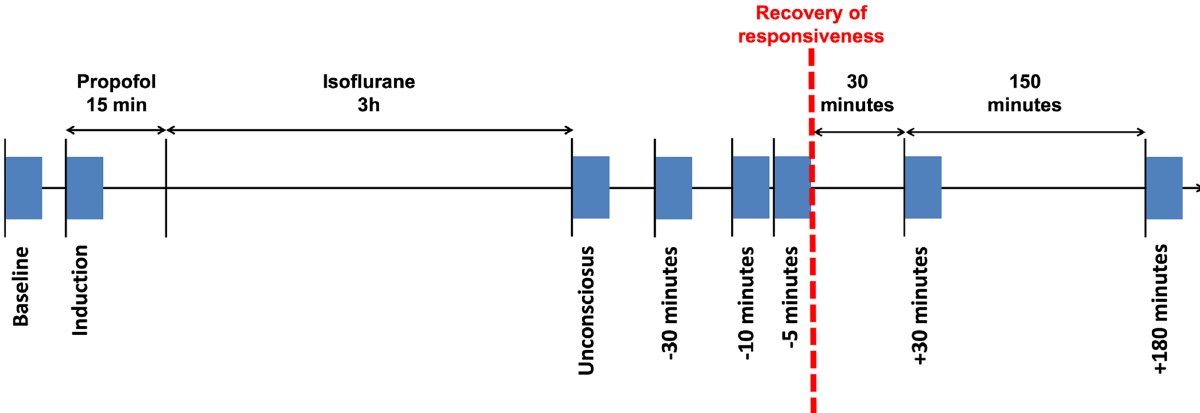
Figure 1. Experimental design and timeline. Timeline of anesthetic protocol and EEG data epochs. Participants received a stepwise increasing infusion rate of propofol for 15 min: 100 mcg/kg/min × 5 min increasing to 200 mcg/kg/min × 5 min, and then to 300 mcg/kg/min × 5 min. Participants then received 1.3 age-adjusted minimum alveolar concentration inhaled isoflurane anesthesia for 3 h. Blue rectangles represent the eight 5-min EEG epochs during which network properties and motifs were calculated: (1) Baseline; (2) Induction; (3) Unconscious; (4) 30 min pre-recovery of responsiveness (ROR); (5) 10 min pre-ROR; (6) 5 min pre-ROR; (7) 30 min post-ROR; and (8) 180 min